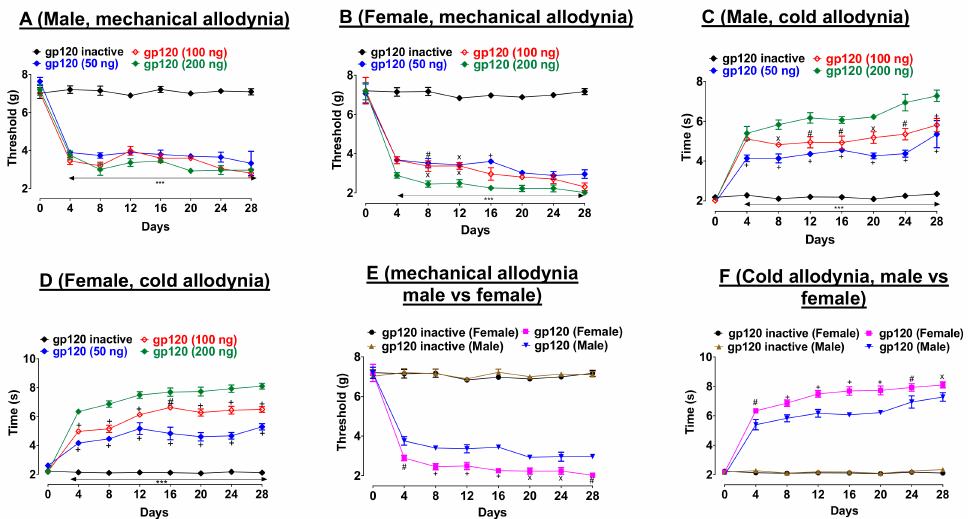
Figure 1. Development of mechanical allodynia and cold hypersensitivity to gp120 in male and female mice. Hind paw withdrawal thresholds to an electronic von Frey device and an acetone drop in male ( A , C ) and female ( B , D ) following intrathecal (i.t.) gp120 injection or heat-inactivated gp120 ( n = six). Compared to male mice, female mice showed lower pain thresholds in von Frey ( E ) and acetone ( F ) tests. Statistical significance of differences between gp120 and gp120 inactive or between male (gp120, 200 ng) and female (gp120, 200 ng) were conducted using two-way ANOVA, multiple comparisons, Bonferroni post hoc. *** p < 0.0001 vs. gp120 inactive ( A – D ) group. + p < 0.001, # p < 0.01, x p < 0.05 comparing gp120 at 200 ng compared to 100 and 50 ng ( A – D ) or comparing gp120 at 200 ng between male to female ( E , F ). Data are expressed as mean ± S.E.M. ( n = six per